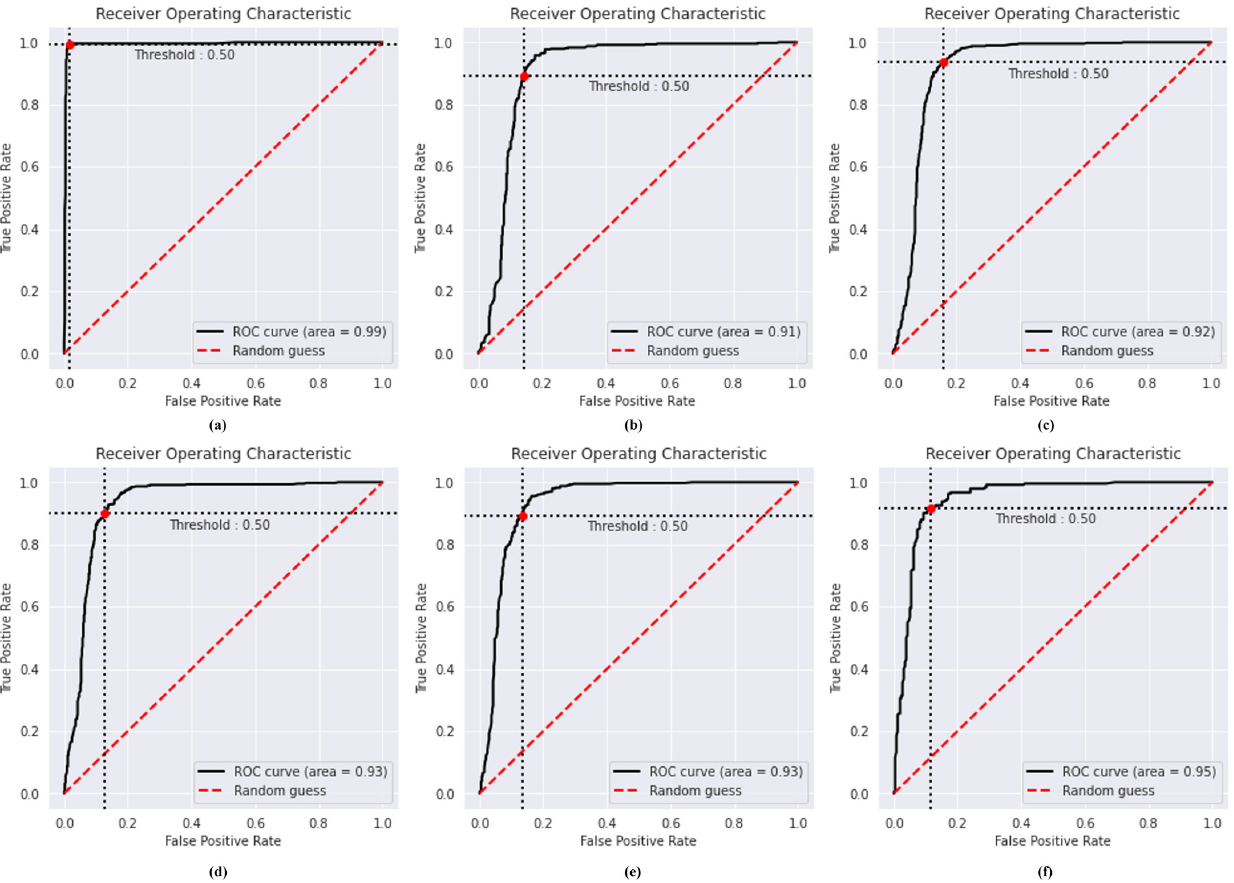
Figure 6. ROC curves; ( a ) proposed model, ( b ) VGG-16, ( c ) VGG-19, ( d ) ResNet-101, ( e ) DenseNet-169, and ( f ) DenseNet-201.